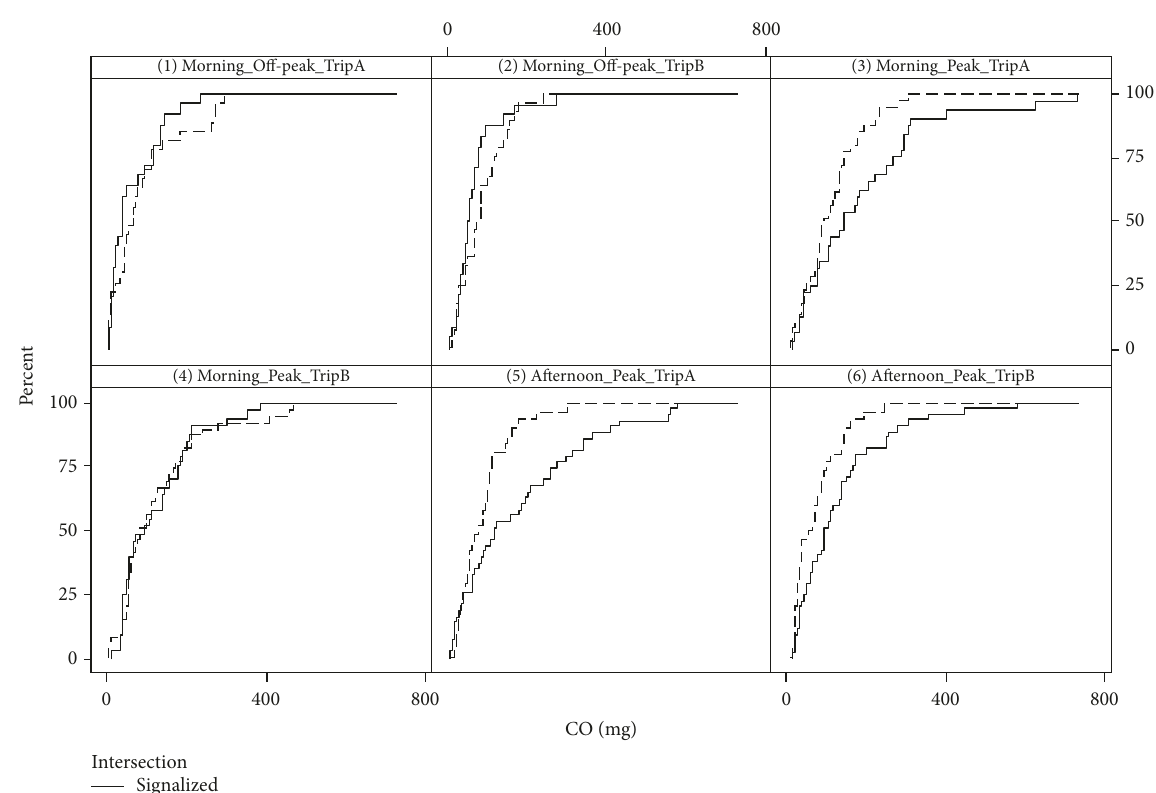
Figure 3: Empirical Cumulative Distribution Functions of CO emissions (mg) by intersection type and trip conditions.